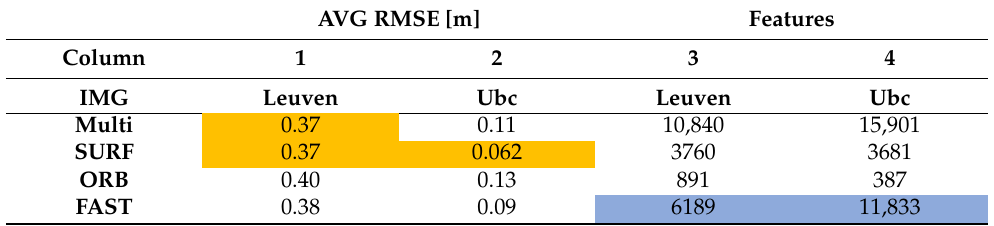
Table 5. Leuven and Ubc average RMSE [m] and the average number of features detected. AVG RMSE [m] Features AVG RMSE [m] Features Column